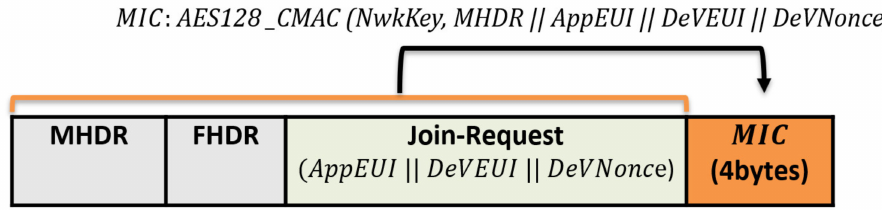
Figure 3. The Join-Request message